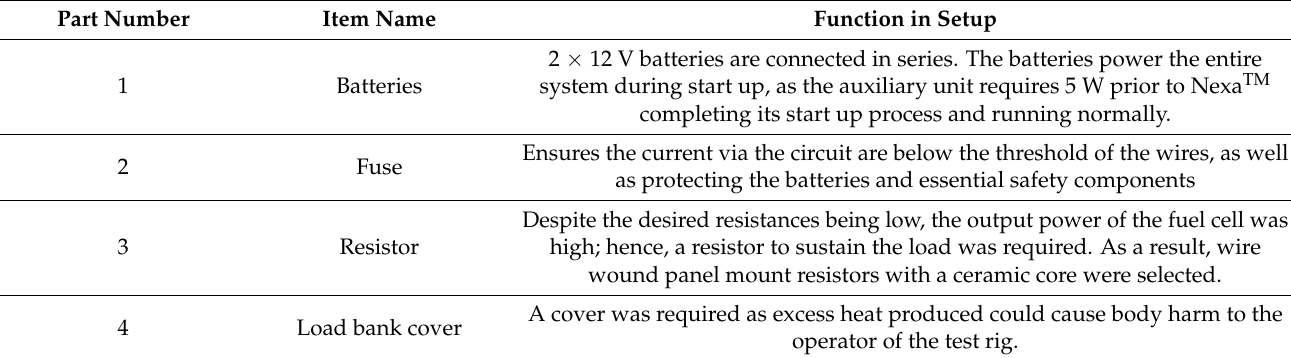
Table 1. Various components